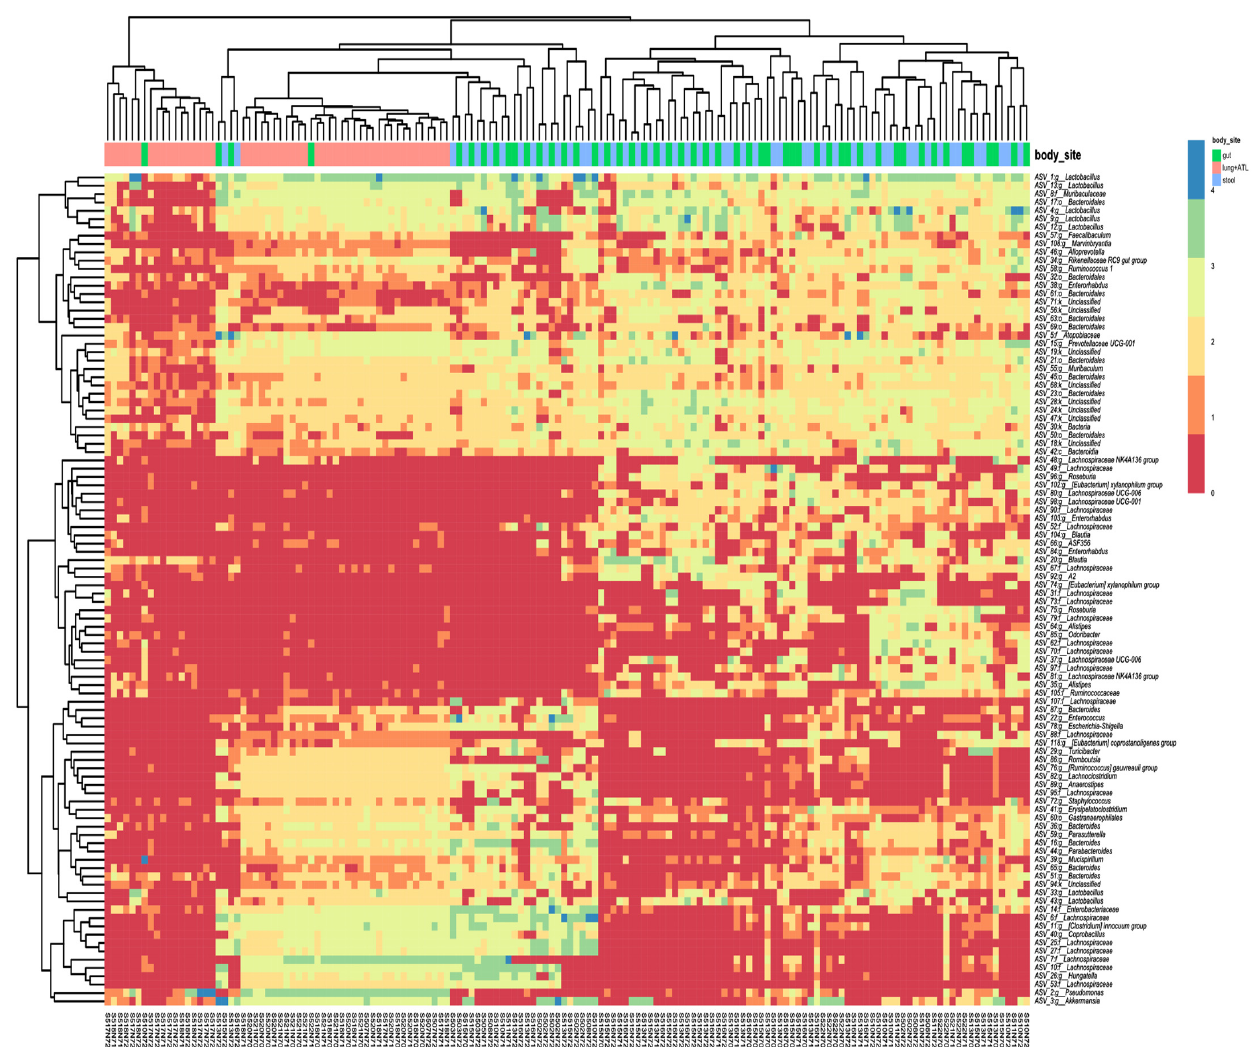
Figure 3. Taxonomic composition and clustering of samples based on the most abundant ASV (top 100). The heat-map showing the abundance of the top 100 ASVs in samples is reported.